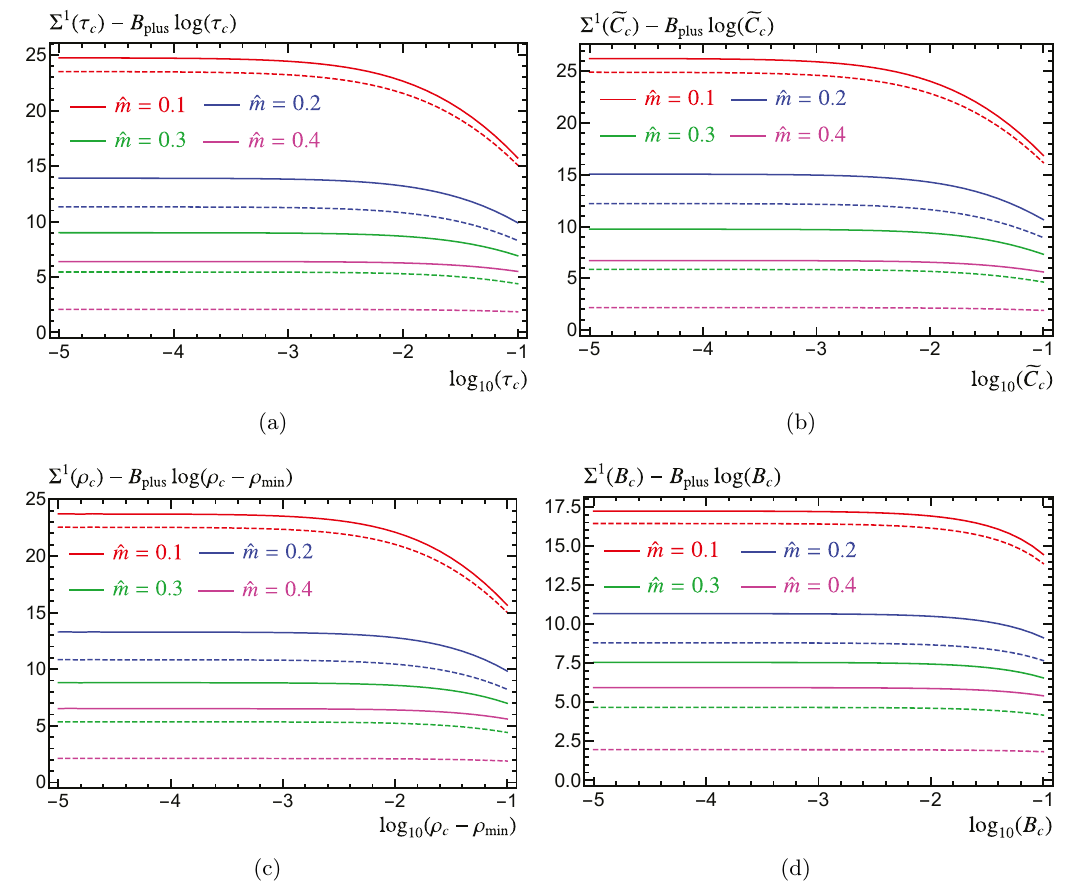
Figure 19 . Numerical determination of the delta-function coe(cid:14)cient. Panel (a) is for thrust, (b) for reduced C-parameter, (c) for heavy jet mass and (d) for jet broadening, respectively. Solid (dashed) lines show the vector (axial-vector) current. Red, blue, green and magenta have reduced masses of ^ m = 0 : 1 ; 0 : 2 0 : 3 and 0 : 4, respectively. Each curve becomes a horizontal line as the event shape approaches its minimal value, reproducing exactly our analytic computations for A e